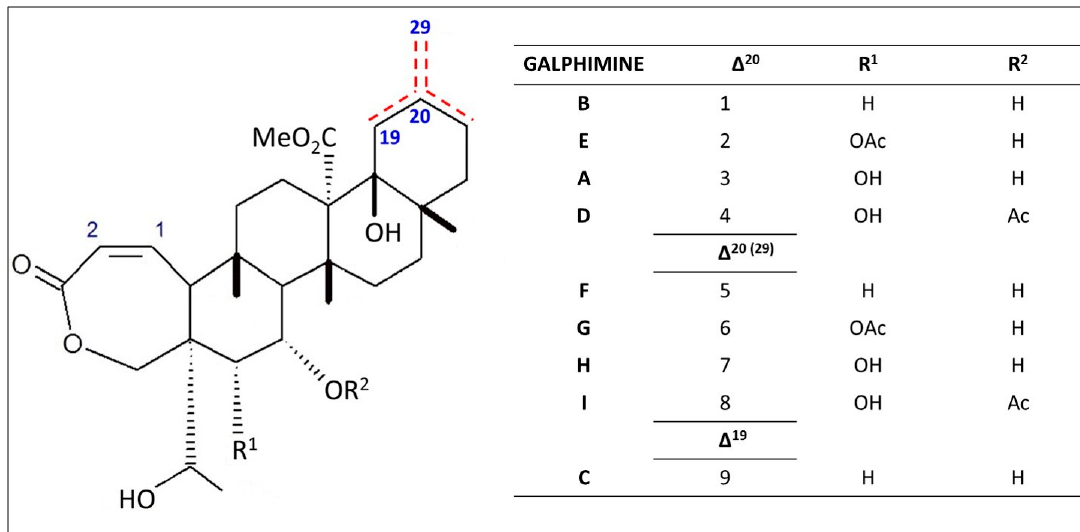
Figure 4. List of galphimines A–I identified in Galphimia glauca.